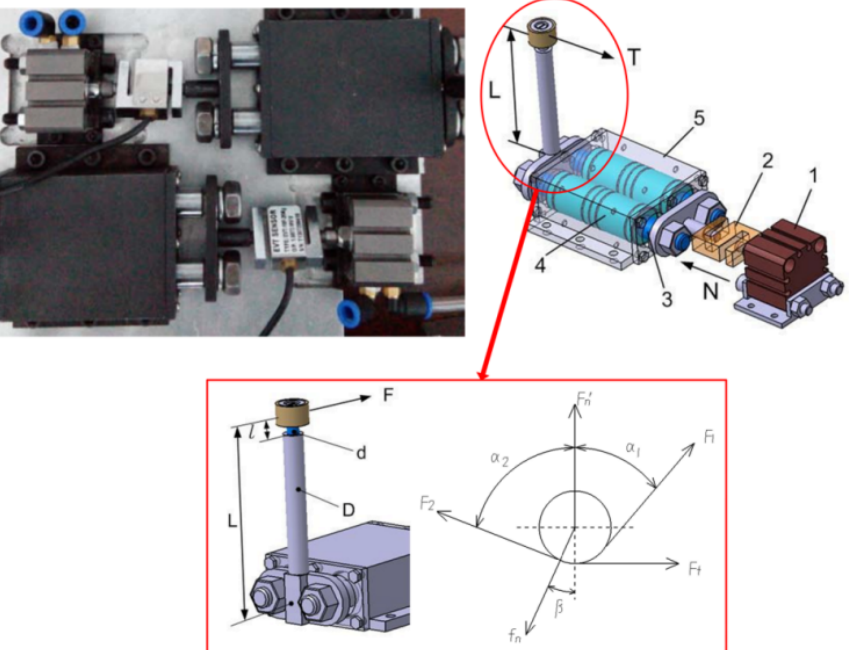
Figure 4. Structure diagram of force control. (1) Low-friction cylinder. (2) S-shaped force sensor. (3) Linear optical shaft. (4) Linear bearing. (5) Bearing block.